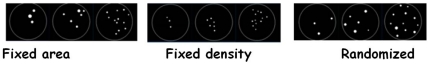
Example of numerical stimuli controlled for area, density and randomized area and density.